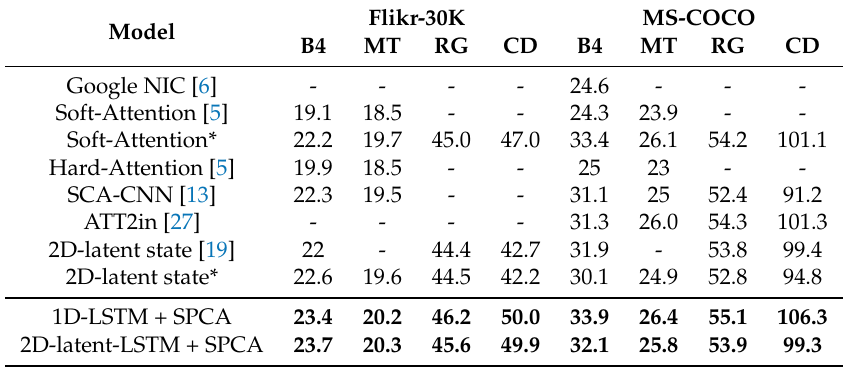
Table 4. Performances compared with state-of-art in Flickr_30K and MS-COCO dataset.